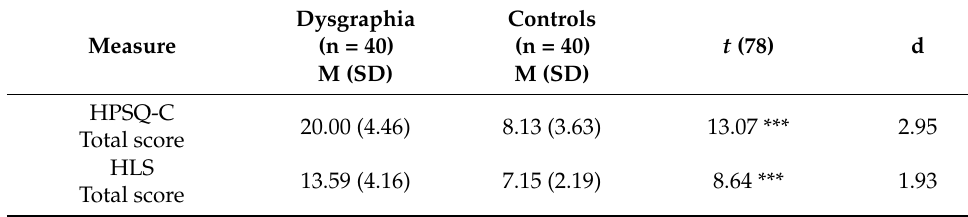
Table 2. Comparison between groups for screening measures.